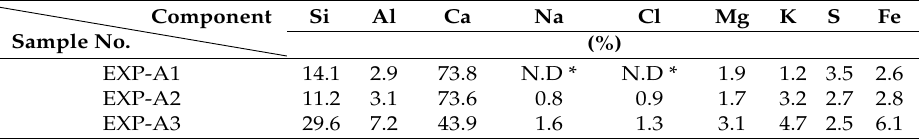
Table 6. SEM-EDS elemental composition of specimens (EXP-A1, EXP-A2, EXP-A3). Component